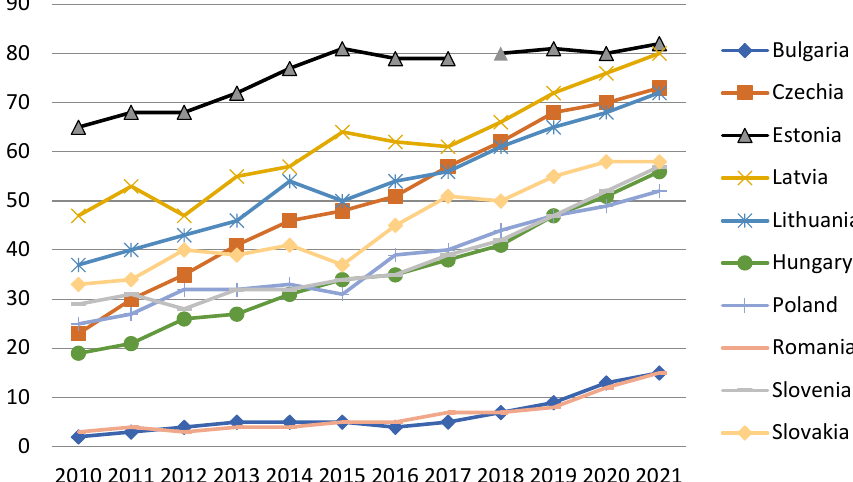
Figure 4. Internet use: internet banking (IB).